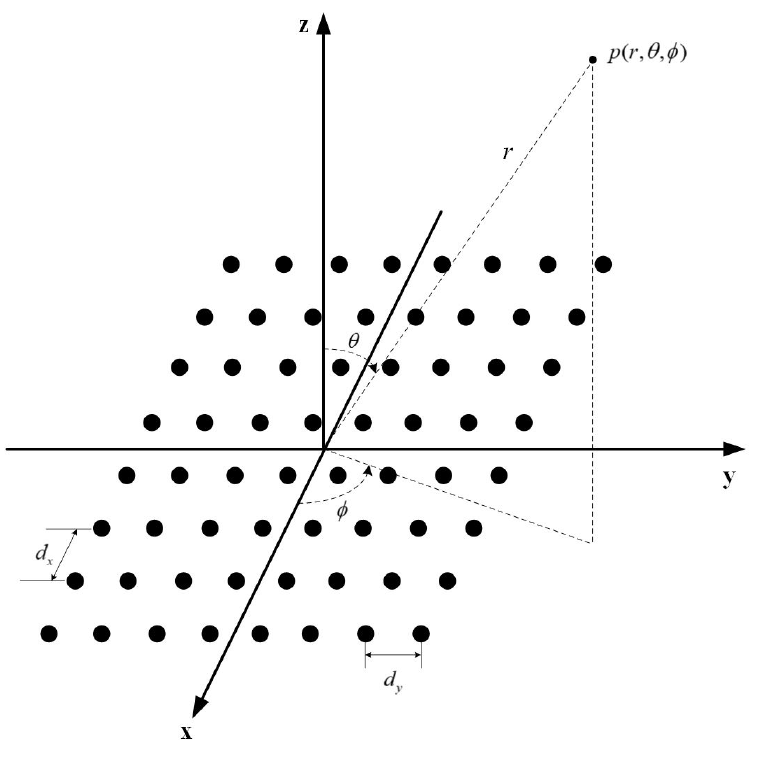
Figure 3. The planar phased array